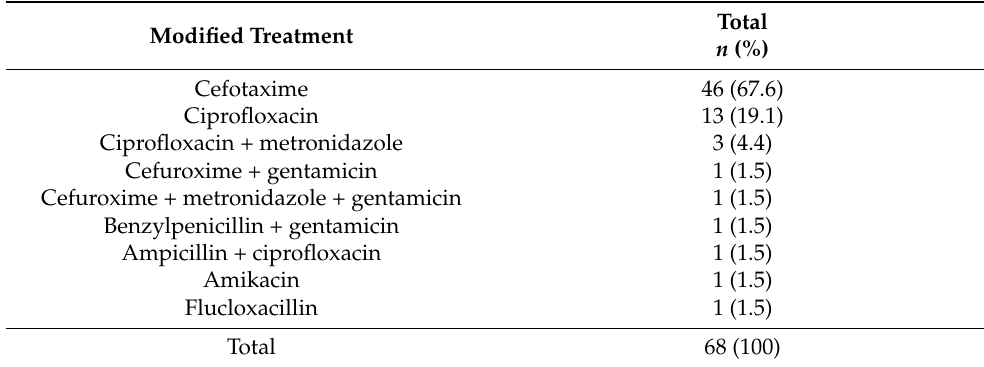
Table 5. Modification in the antimicrobial treatment among neonates admitted with suspected sepsis at Komfo Anokye Teaching Hospital, Ghana, between January 2021 and December 2021.